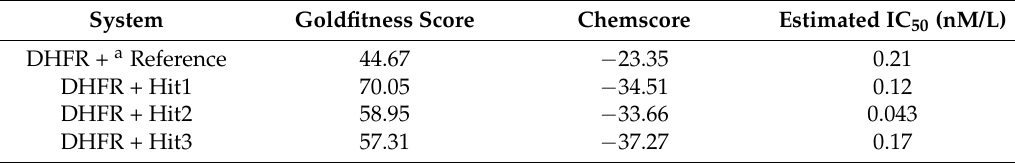
Table 4. Comparison of Goldscore and Chemscore of dihydrofolate reductase (DHFR) in complex with the reference, Hit1, Hit2, and Hit3.